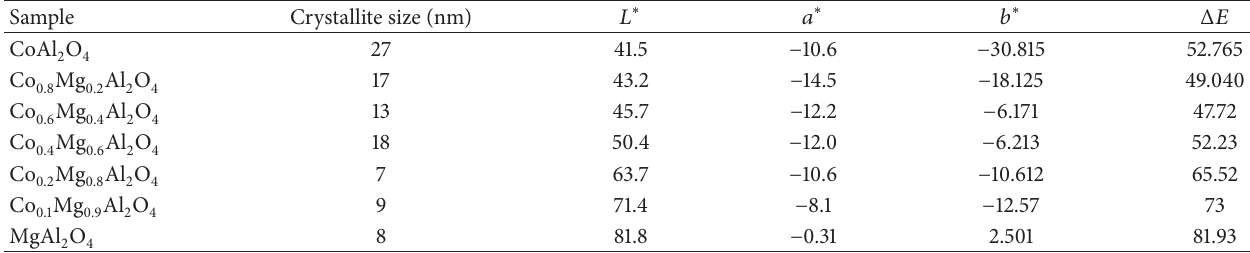
Table 1: Crystallite size and colorimetric analysis of the calcined samples.